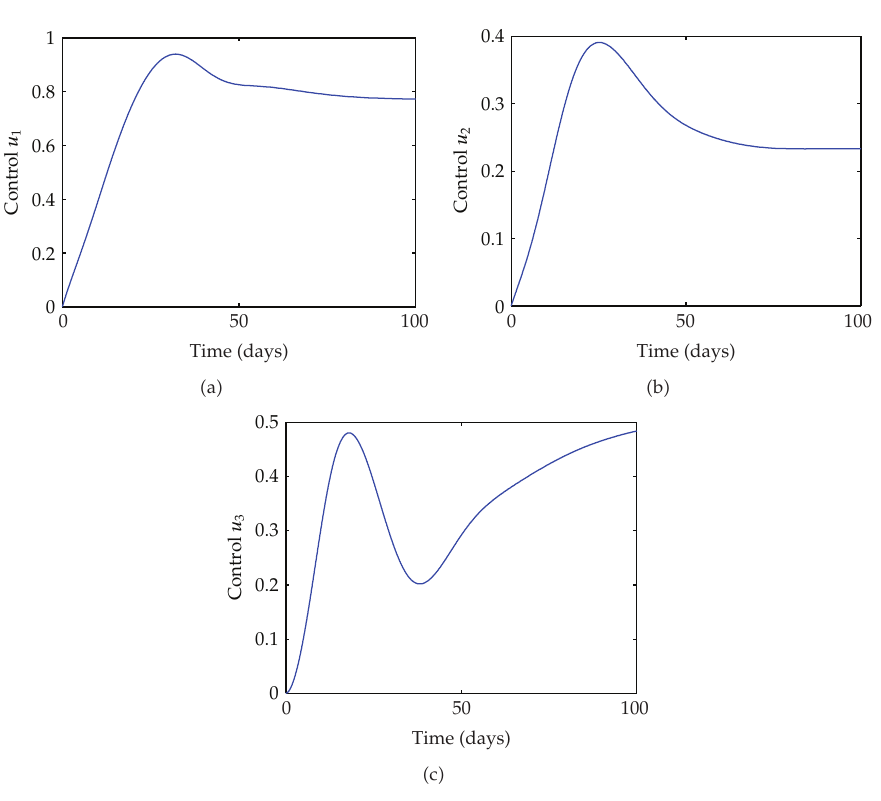
Figure 5: The plot represents the three controls (cid:6) 3.14 (cid:7) when A 1 (cid:9) 1, A 2 (cid:9) 1, A 3 (cid:9) 0 . 00001, B 1 (cid:9) 200, B 2 (cid:9) 50, B (cid:9) 3